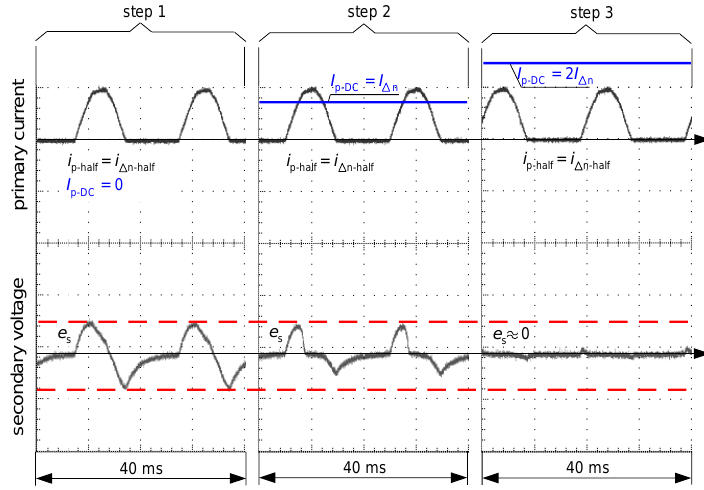
Figure 19. Oscillograms of the induced secondary voltage e s in case of the iron core of flat hysteresis loop (as in Figure 15b). Primary current i p composed of pulsating DC (half-wave) waveform ( i p-half = i ∆ n-half ) and DC component ( I p-DC ) of the consecutive values: I p-DC = 0 (step 1), I p-DC = I ∆ n (step 2), I p-DC = 2 I ∆ (step 3).